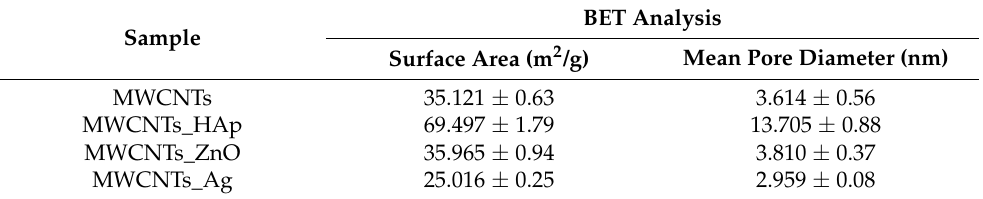
Table 4. BET surface area analysis of MWCNTs and MWCNTs decorated with